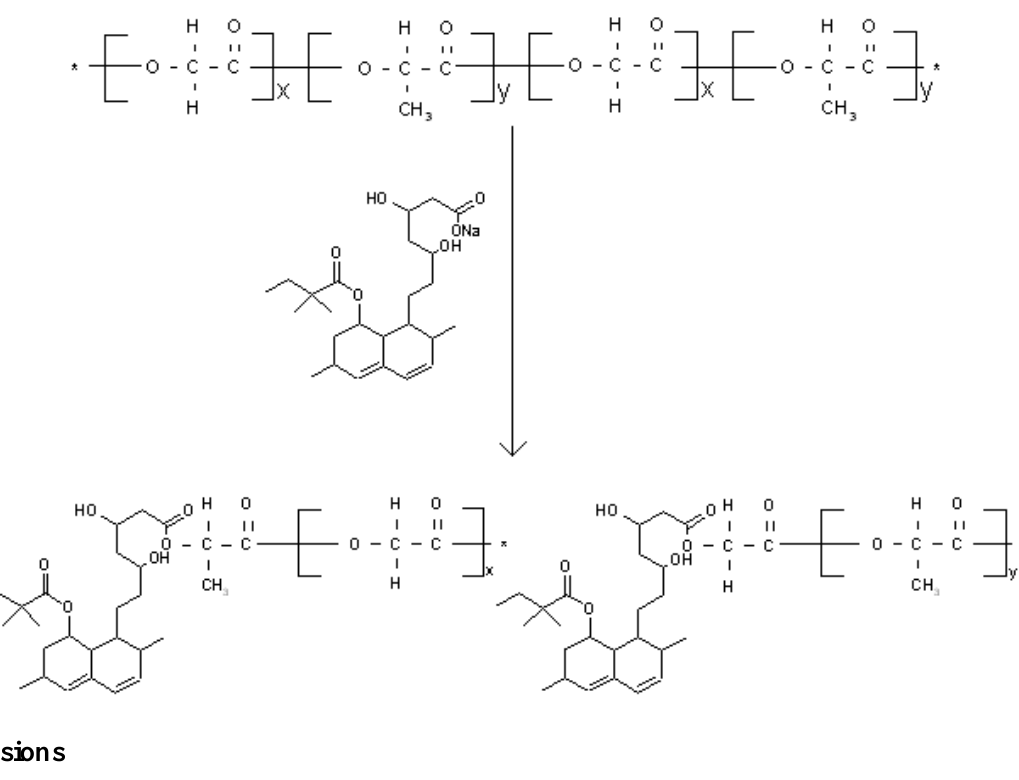
Figure 4. Schematic of proposed mechanism of PLGA ester bond cleavage in presence of saponifiedsimvastatin and subsequent covalent bonding of PLGA and